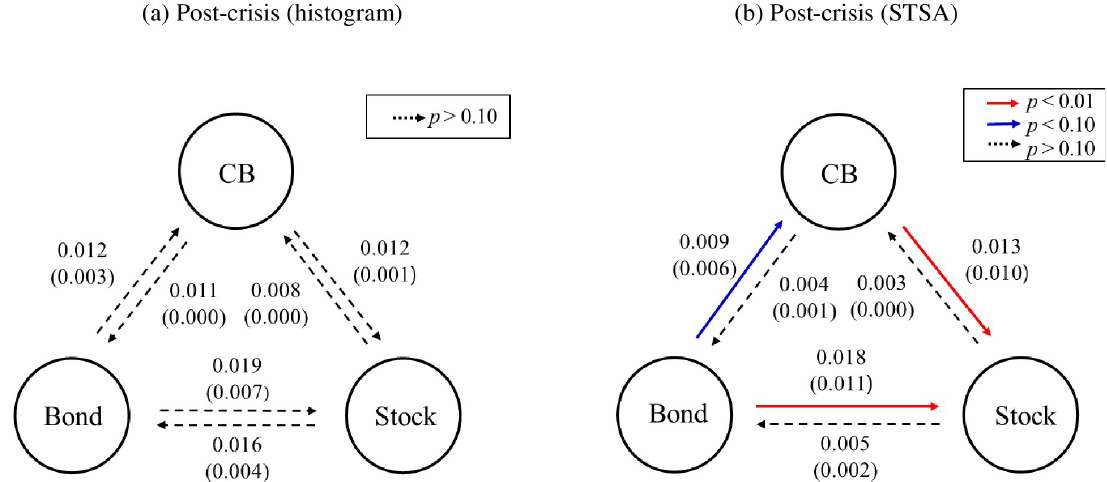
Fig 4. Information flow among the CB, stock, and bond markets during the post-crisis period. The arrow indicates the direction of the causal link, the color represents the significance level (red and blue lines represent statistically significant information flows with a p - value lower than 0.01 and 0.10, respectively, and the dashed line indicates insignificant TE with a p -value higher than 0.10), and p means p -value. The number denotes the estimated value of TE, and the value in parentheses stands for ETE. The significance level was evaluated by bootstrapping the underlying Markov process [26, 57]. We further apply the quantile-based TE for robustness check. In particular, cutoff points of 0.05 and 0.95 are used for the estimation (see S1